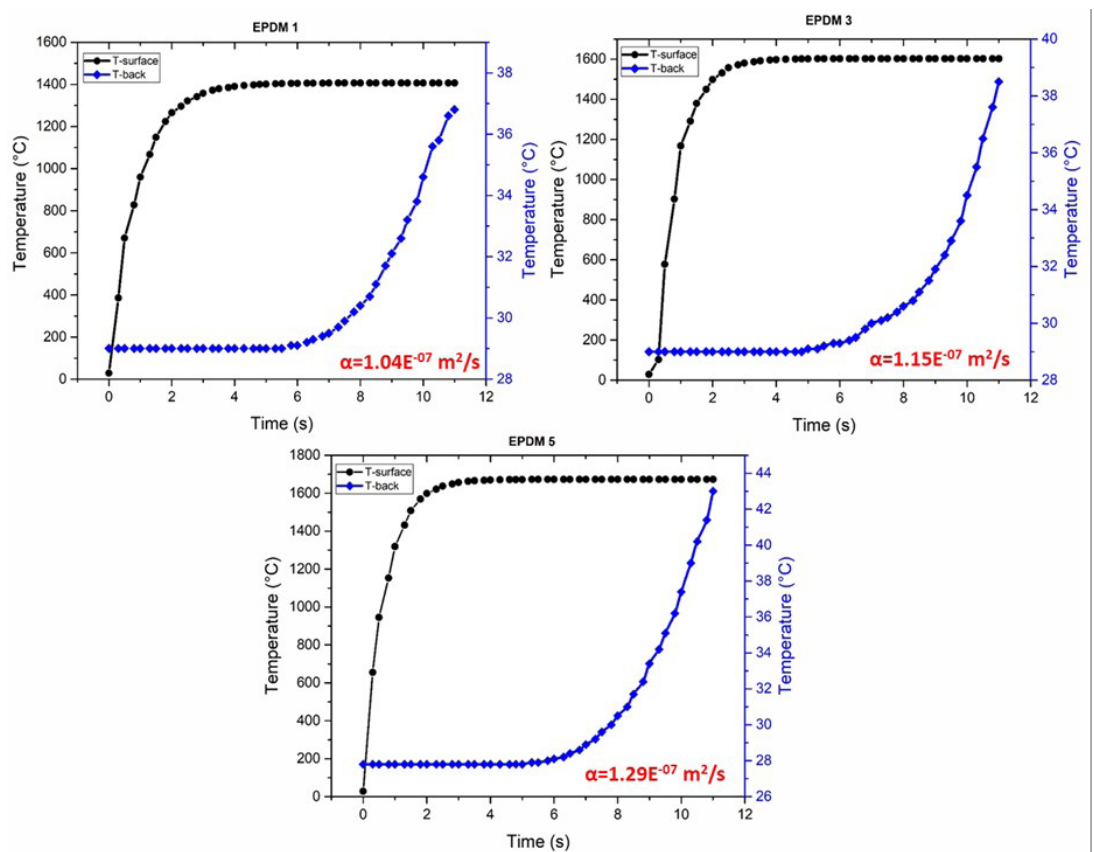
Figure 9. Temperature profile and thermal diffusivity of EPDM 1, EPDM 3, and EPDM 5 samples.